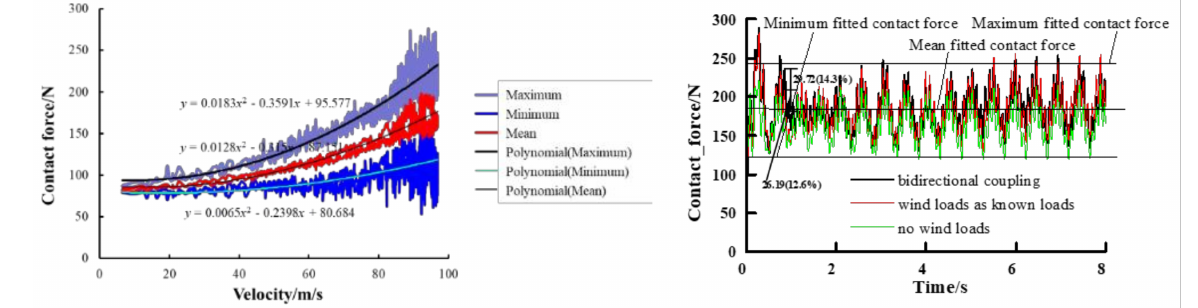
Figure 10. Contact forces between pantograph and catenary simulated and fitted under open air at 360